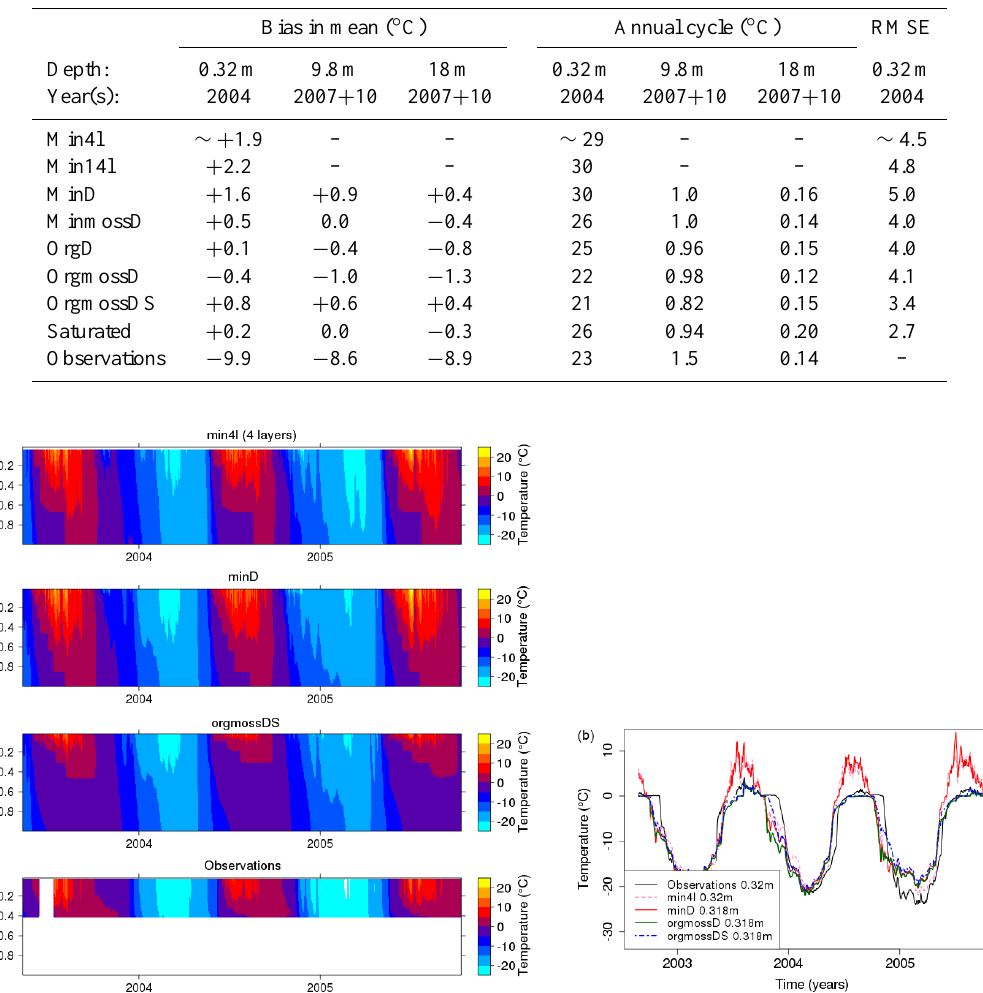
Figure 6. (a) Soil temperatures in active layer, simulated (top three plots) and observed (lower plot). The simulations are, from top, the standard four-layer JULES set-up (min4l), deeper and better-resolved soil (minD), and adding to this organic soils, moss, and the improved snow scheme (orgmossDS). Observations are for a polygon centre (see Fig. 3). (b) Active layer soil temperatures at 32cm depth, simulated and observed. The lines represent horizonal slices through the contour plots in Fig. 6a. Additionally, the simulation orgmossD is shown, which includes organic soils and moss but not the new snow